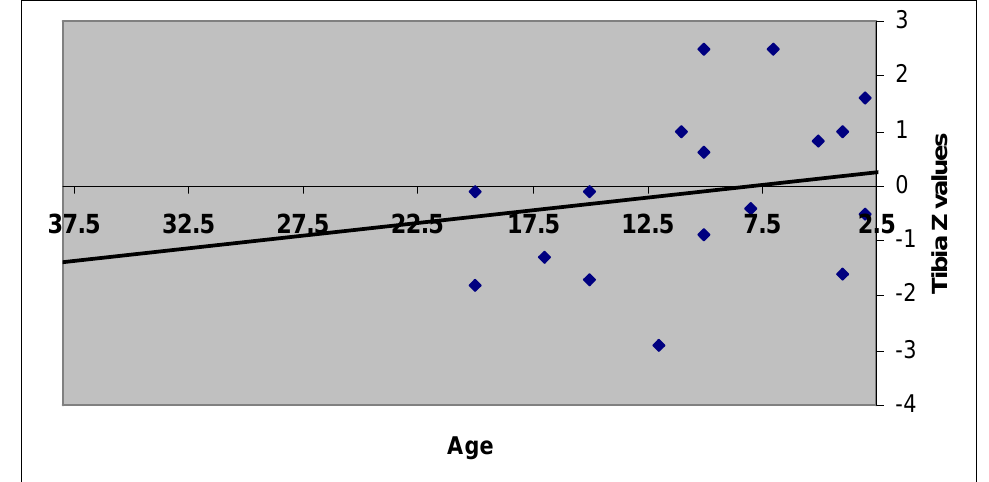
FIGURE 3. A connection between aging and low Z